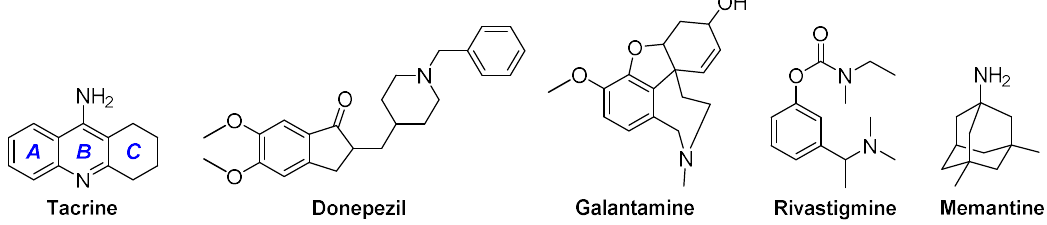
Figure 2. Structures of clinically used Alzheimer’s disease (AD) drugs. Tacrine (discontinued), donepezil, galantamine, and rivastigmine are all AChEi. Memantine is an N -methyl- D -aspartate receptor (NMDAR) antagonist. The tricyclic rings of tacrine are labeled A–C for discussion purposes.